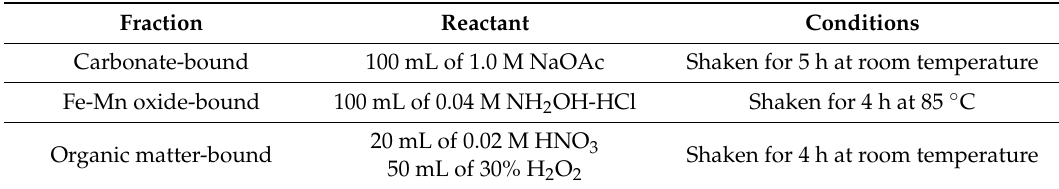
Table 1. Summary of the three-step sequential extraction procedure